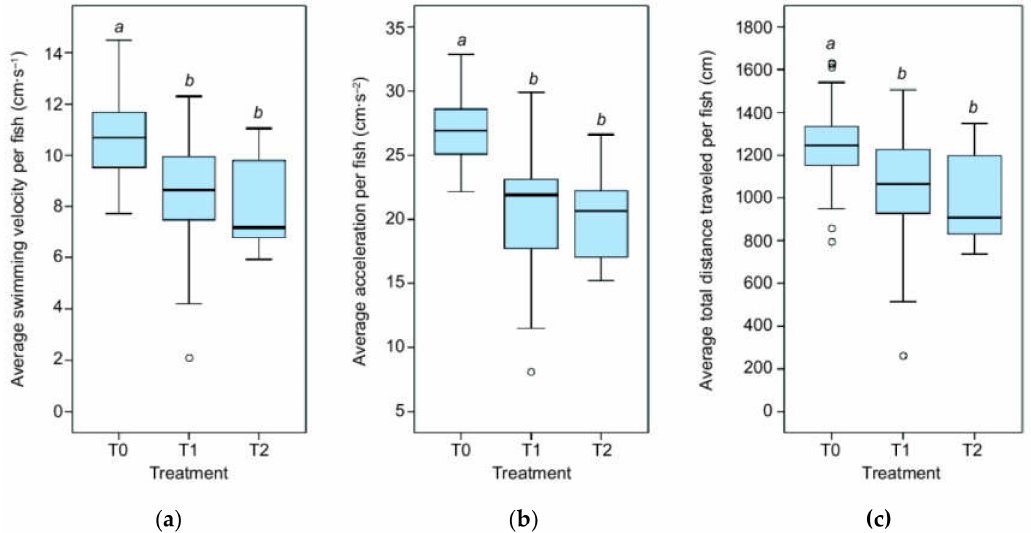
Figure 1. Fish kinematics. ( a ) Average swimming velocity, ( b ) acceleration, and ( c ) distance traveled per fish in the three treatment levels: T0 = control, T1 = mild depletion, T2 = high depletion; “a” and “b” above the boxplots indicate a significant difference between two treatments, whereby the same letter indicates no statistically significant difference by Kruskal-Wallis test.